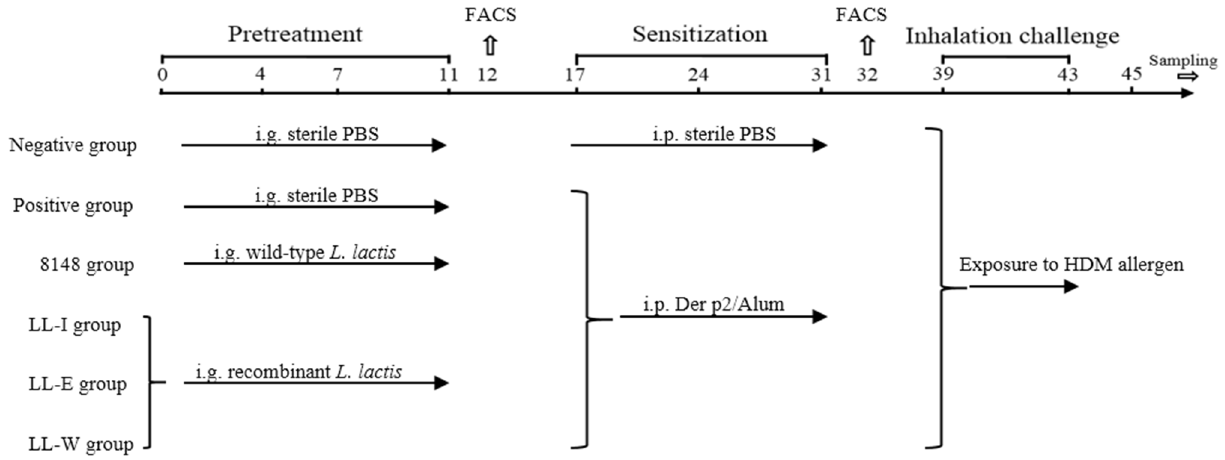
Figure 1. Experimental design. On days 0–4 and 7–11, BALB/c mice were daily received PBS, recombinant or wild-type L. lactis via the oral route. On days 17, 24 and 31, mice underwent intraperitoneal (i.p.) injection sensitization with the mixture of Der p2/Alum or sterile PBS. From day 39 to 43, all groups were inhalation challenged with aerosolized HDM allergen over a 45-min period. Positive and Negative group served as positive and negative control in this study,